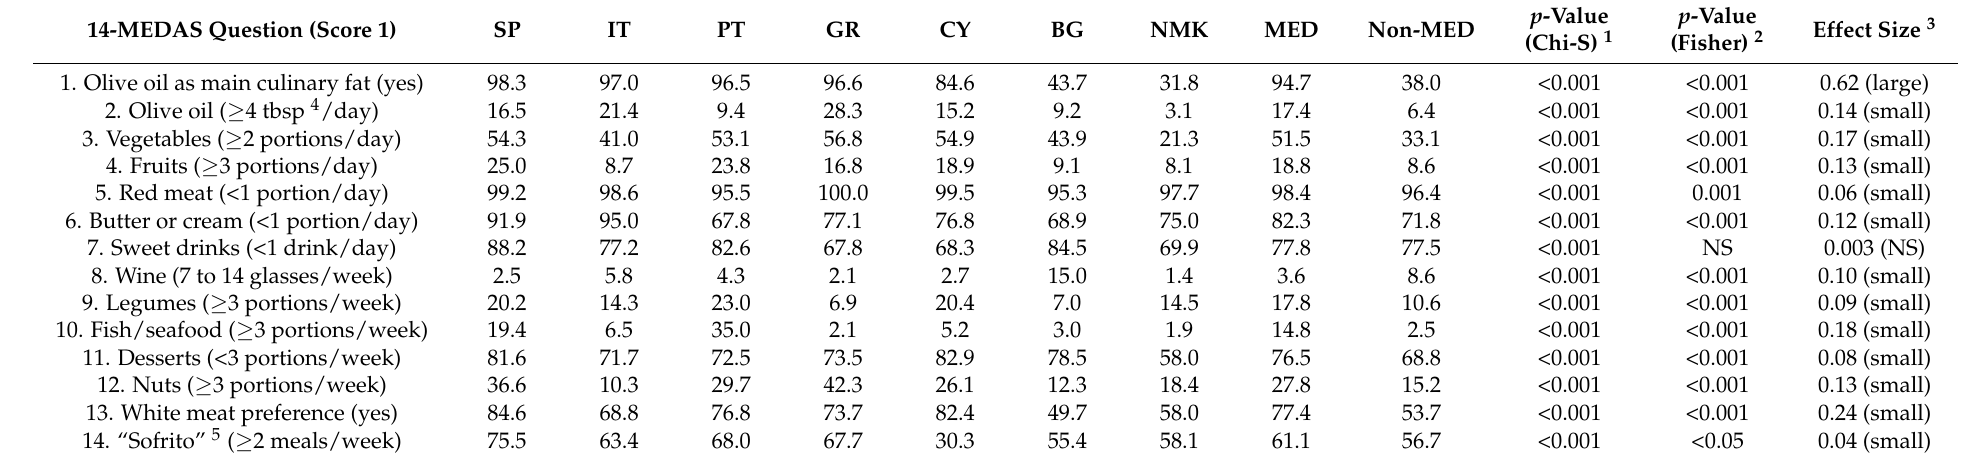
Table 2. Food choices in the sample population for each individual country and each group of countries: percentage of participants scoring 1 (within Mediterranean diet recommendations) for each question of the 14-MEDAS. SP: Spain; IT: Italy; PT; Portugal; GR: Greece; CY: Cyprus; BG: Bulgaria; NMK: Republic of North Macedonia. MED: all Mediterranean countries together; Non-MED: all non-Mediterranean countries